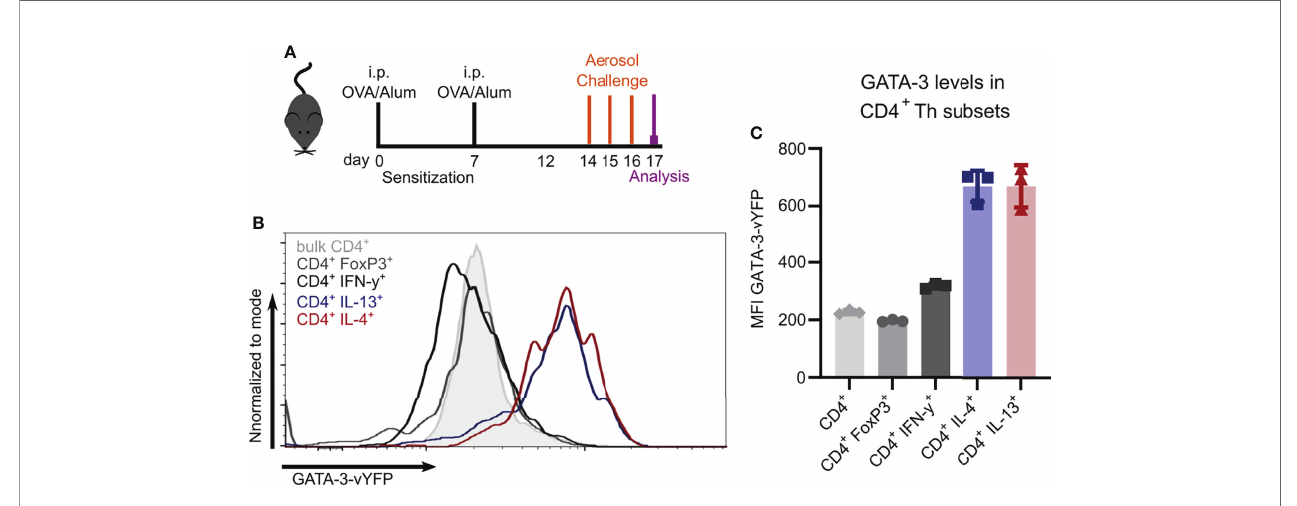
FIGURE 2 | GATA-3-vYFP expression signal correlates with Th2 cytokine expression. GATIR mice were sensitized with OVA/Alum by two intraperitoneal (i.p.) injections on day 0 and 7. On day 14, 15 and 16 they were challenged with aerosolized OVA for 20 min and analyzed on day 17. (A) Experimental setup. (B) GATA- 3-vYFP expression levels in indicated CD4 + T cell subsets in the lung compared to bulk CD4 + T cells (grey fi lling) and (C) quanti fi cation of the mean fl uorescence intensity (MFI). Data is shown as mean ± SD, n=3; statistical differences are not indicated for better